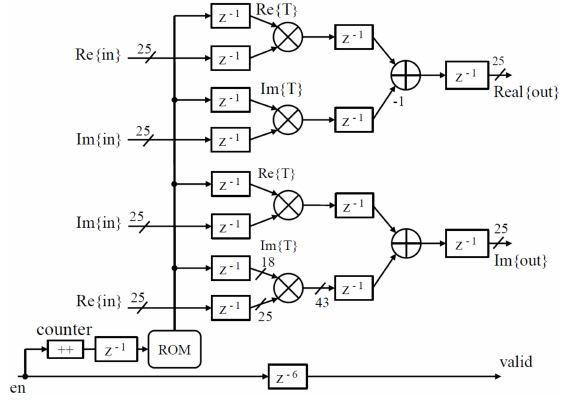
Figure 3. Block diagram of the FFT unit.